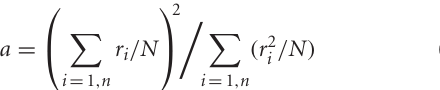
FIGURE 3 | The architecture of an autoassociation or attractor neural network (CANN) (see text).